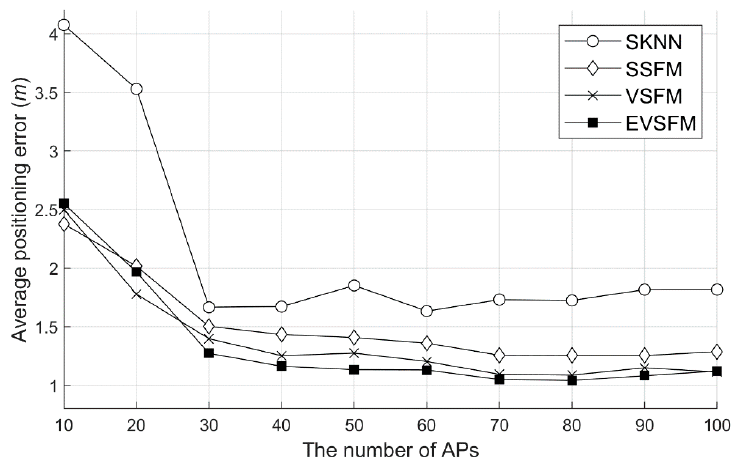
Figure 12. Positioning average error by the positioning algorithms (before recollection, # 400 training samples). SKNN: the basic single positioning technique and EVSFM: extended Viterbi algorithm and signal fluctuation matrix fusion tracking method.